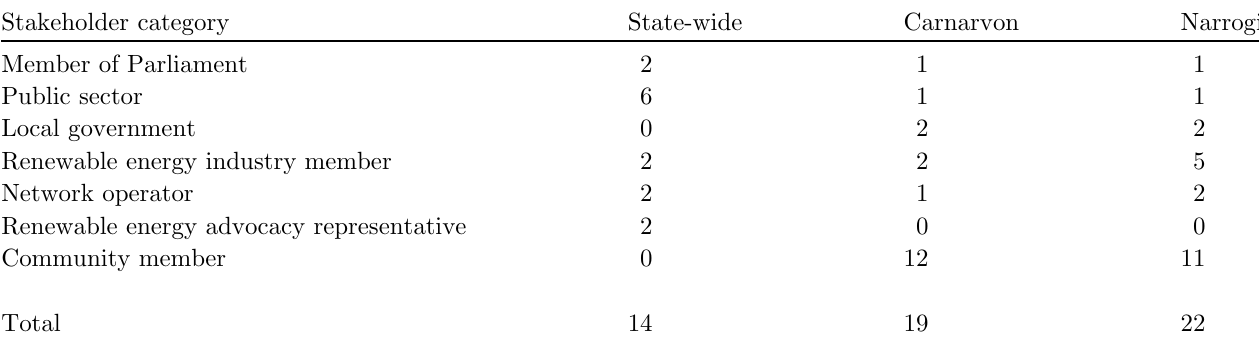
Table 1. Stakeholders interviewed, by geographic region of in fl